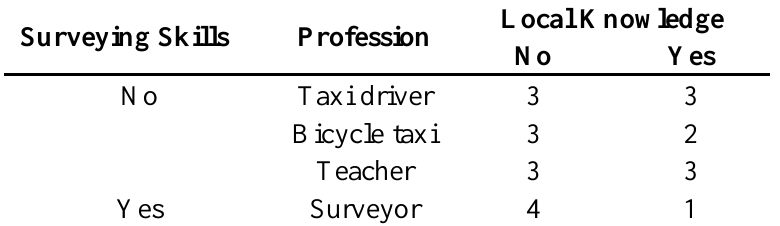
Table 1. Number of image interpreters grouped according to their profession and local knowledge and surveying